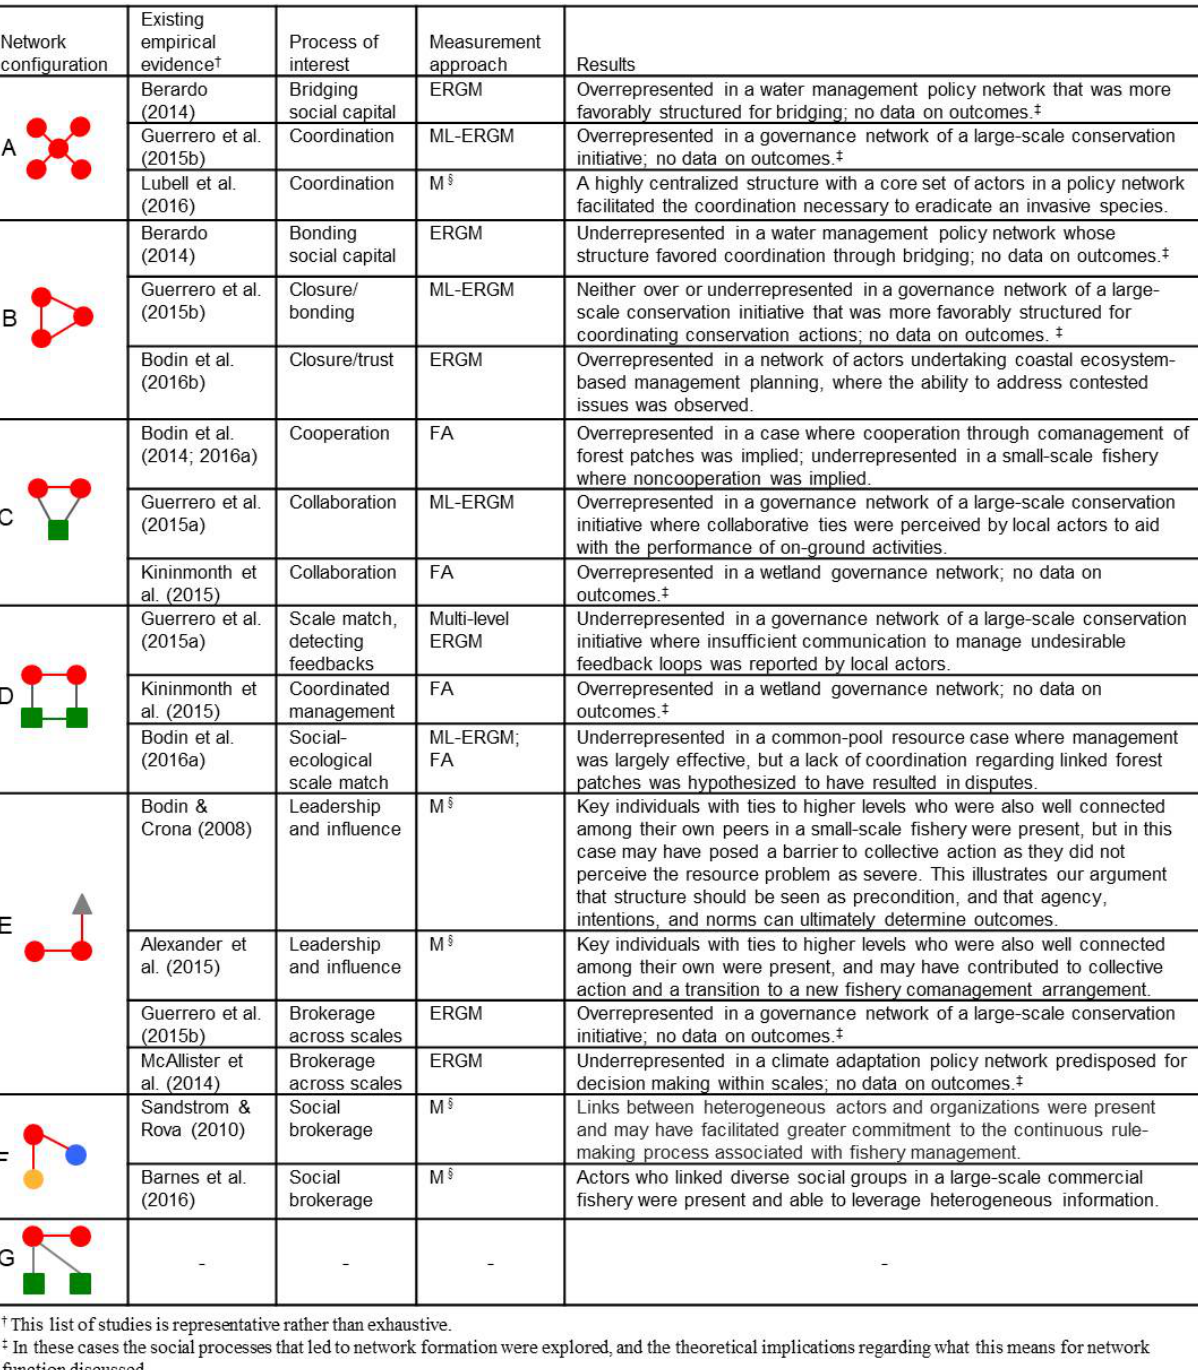
Fig. 4. Empirical investigations of network configurations in related environmental governance contexts (ERGM = exponential random graph model; ML-ERGM = multilevel exponential random graph model; FA = descriptive frequency approach; M = mixed